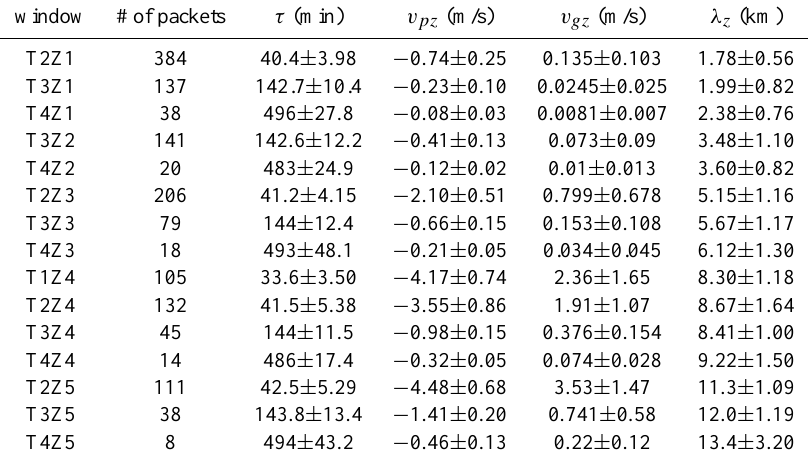
Table 5. Mean ± standard deviation of vertical group velocity v gz , vertical phase velocity v pz , characteristic wave period τ and vertical wave length λ z of the sampled wave